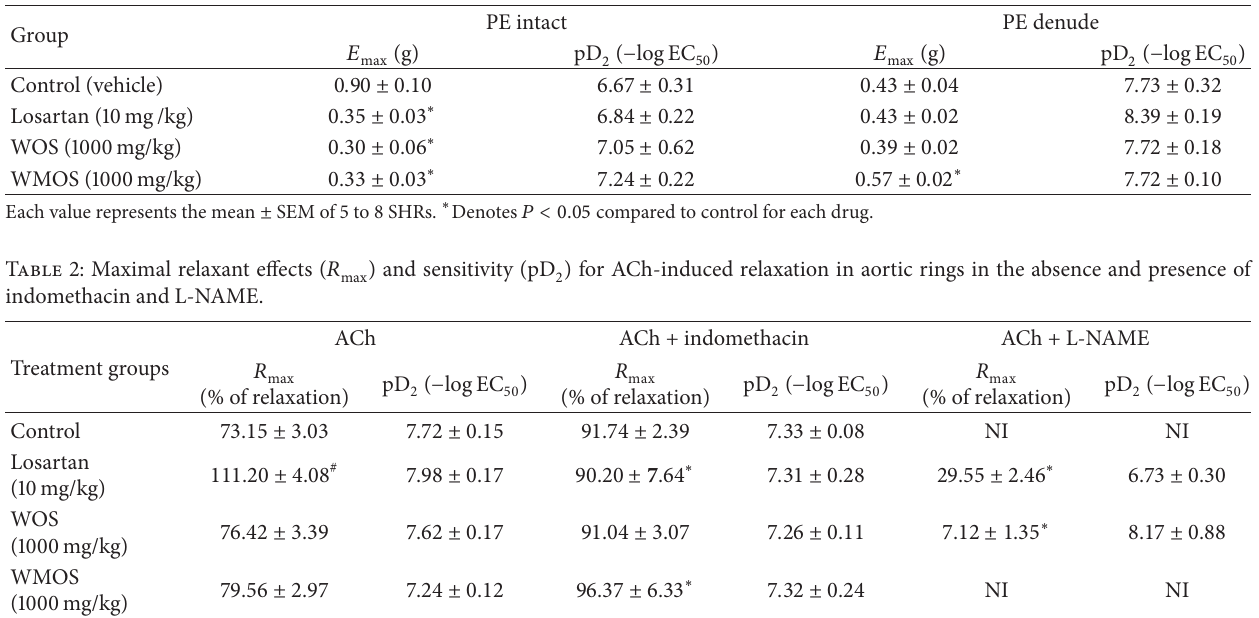
Table 1: Maximal contractile ( 𝐸 max ) responses and sensitivity (pD